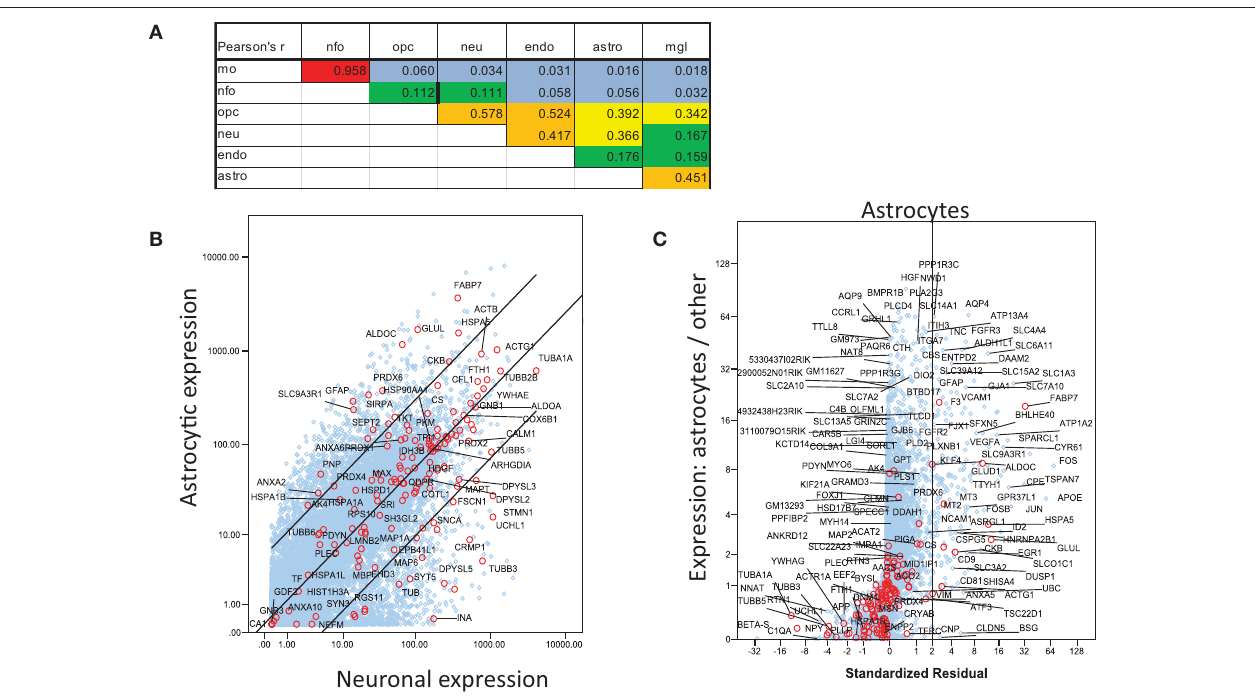
FIGURE 1 | Analysis of mouse RNAseq data from http://jiaqianwulab.org/resource.htm (Zhang et al., 2014; Dong et al., 2015). (A) Correlation coefficients between cell types for all genes. (B) Linear regression of gene expression in ASTRO and NEU. Genes for proteins included in Table 1 are represented by red circles and labeled where space permits. Other genes are represented by blue circles. Center line represents best fit and outer lines 95% confidence limits after log transformation of data. (C) Multiple regression of ASTRO against other cell types. Linear regression of untransformed expression data for ASTRO against data for MO, OPC, NEU, and ENDO, was performed, and standardized residuals were computed. NFO were omitted from all multiple correlations because of their very high correlation with MO. Standardized residuals are potted on X-axis. The Y axis represents the ratio between expression level in ASTRO and the average expression levels in the other five cell types. Genes with standardized residual values above two (i.e., to the right of the vertical line) were considered enriched in astrocytes. Colors are as in (B) ; both red and blue circles are labeled where space